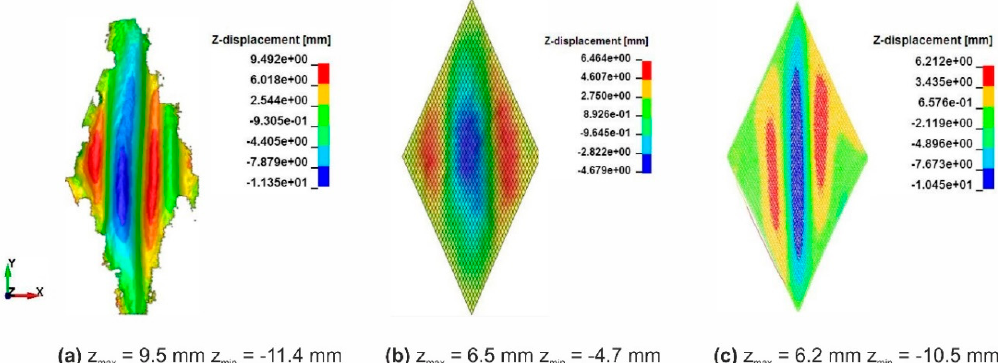
Figure 12. Optical comparison of the wrinkle size of fabric variant 1 at 40° shear angle: ( a ) One representative sample from experimental tests, ( b ) simulation result from macro-scale model, ( c ) simulation result from meso-scale model.